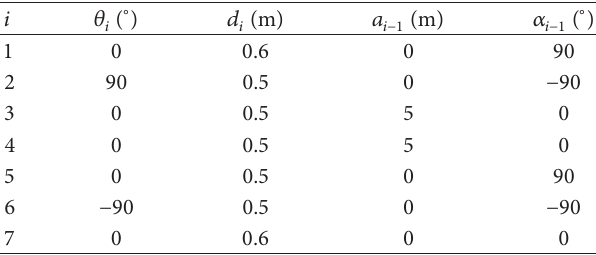
Table 1: DH parameters of space manipulator.